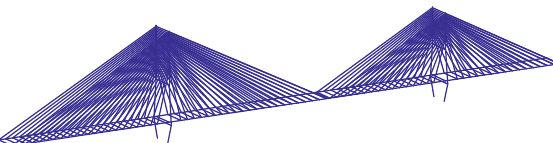
Figure 7: Simplified beam element model.